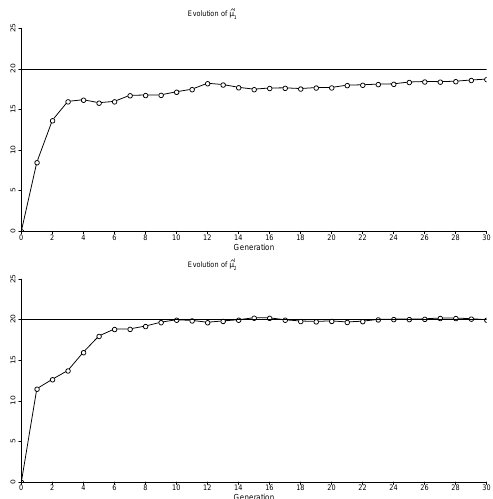
Figure 2. Evolution of the estimates (cid:98) µ I